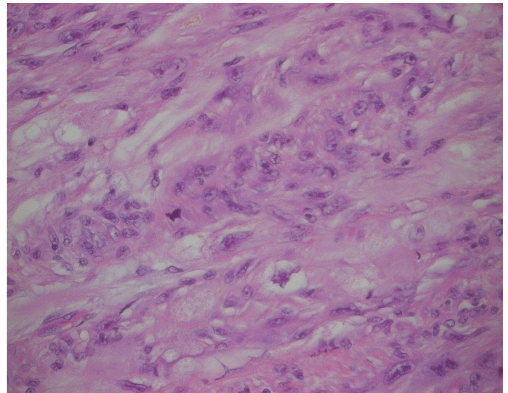
Figure 5: The tumour cells show large, pleomorphic nuclei with prominent nucleoli. An abnormal mitotic figure is identified (Stain: H&E, × 40).